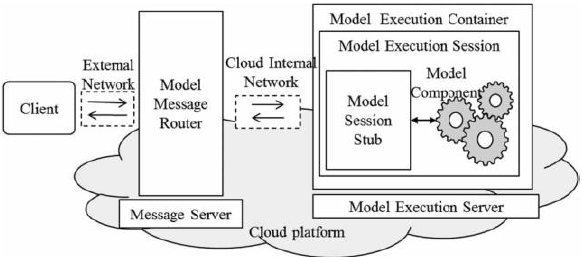
Figure 10 Architecture for the distributed model